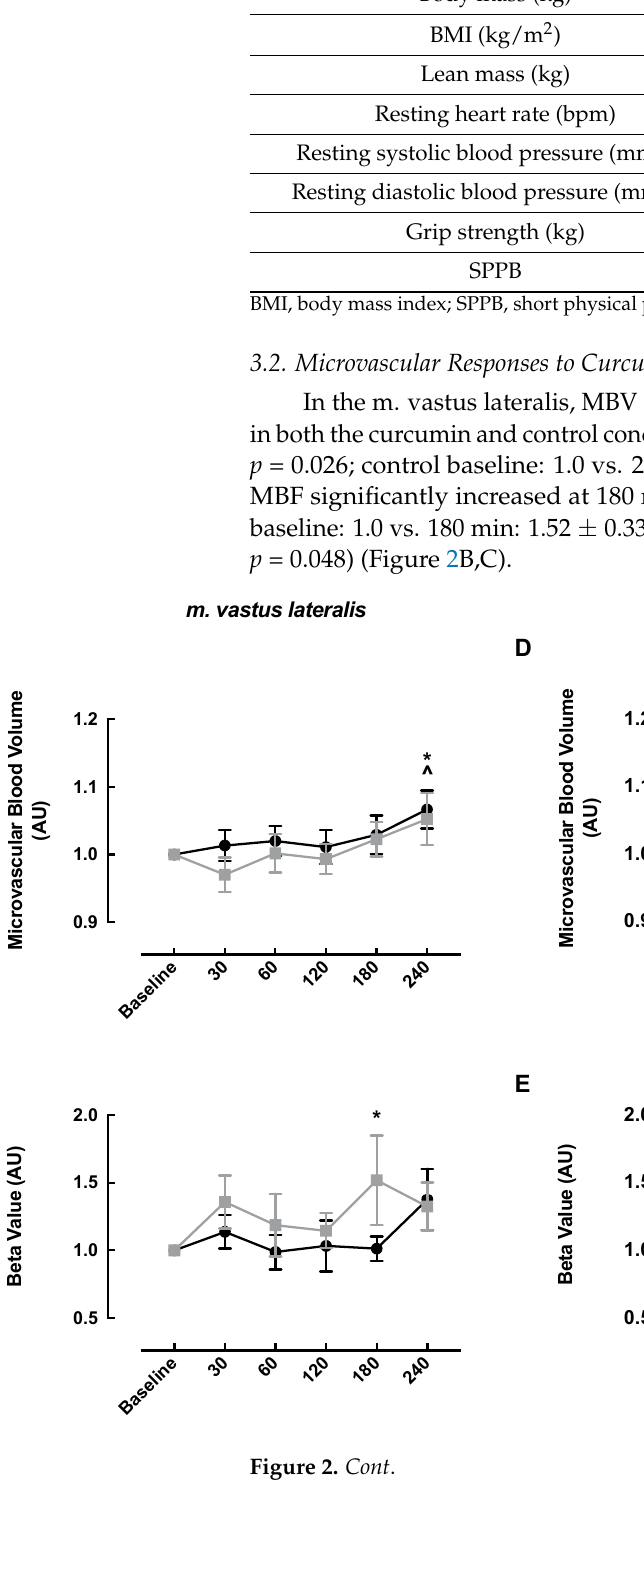
Figure 2. The impact of curcumin alongside oral nutritional supplement feeding on microvascular blood volume ( A , D ), microvascular flow velocity ( B , E ), and microvascular blood flow ( C , F ) in the m. vastus lateralis ( A – C ) and m. tibialis anterior ( D – F ) of healthy older adults. A ~ denotes a signif- icant difference between groups ( p < 0.05); ^ denotes significant difference from control baseline ( p < 0.05); * denotes significant difference from curcumin baseline ( p < 0.05). 3.3. Macrovascular Responses to Curcumin Supplementation LBF significantly increased from baseline in both conditions early in the fed phase (curcumin: baseline: 253.5 ± 28.5 vs. 25 min: 333.5 ± 31.5 mL/min, p = 0.001; control: base- line: 271.4 ± 22.0 vs. 55 min: 376.3 ± 25.3 mL/min, p < 0.0001), and the onset of increased